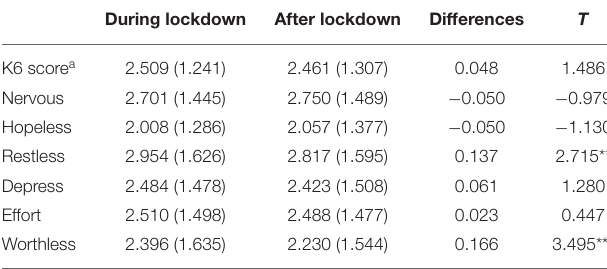
during and after lockdown ( N = 525). During lockdown After